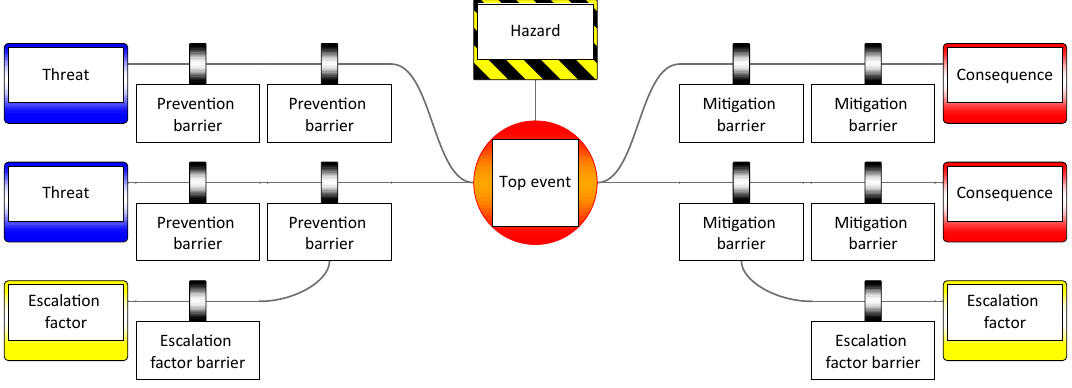
Figure 2. Generic structure of a Bowtie diagram.